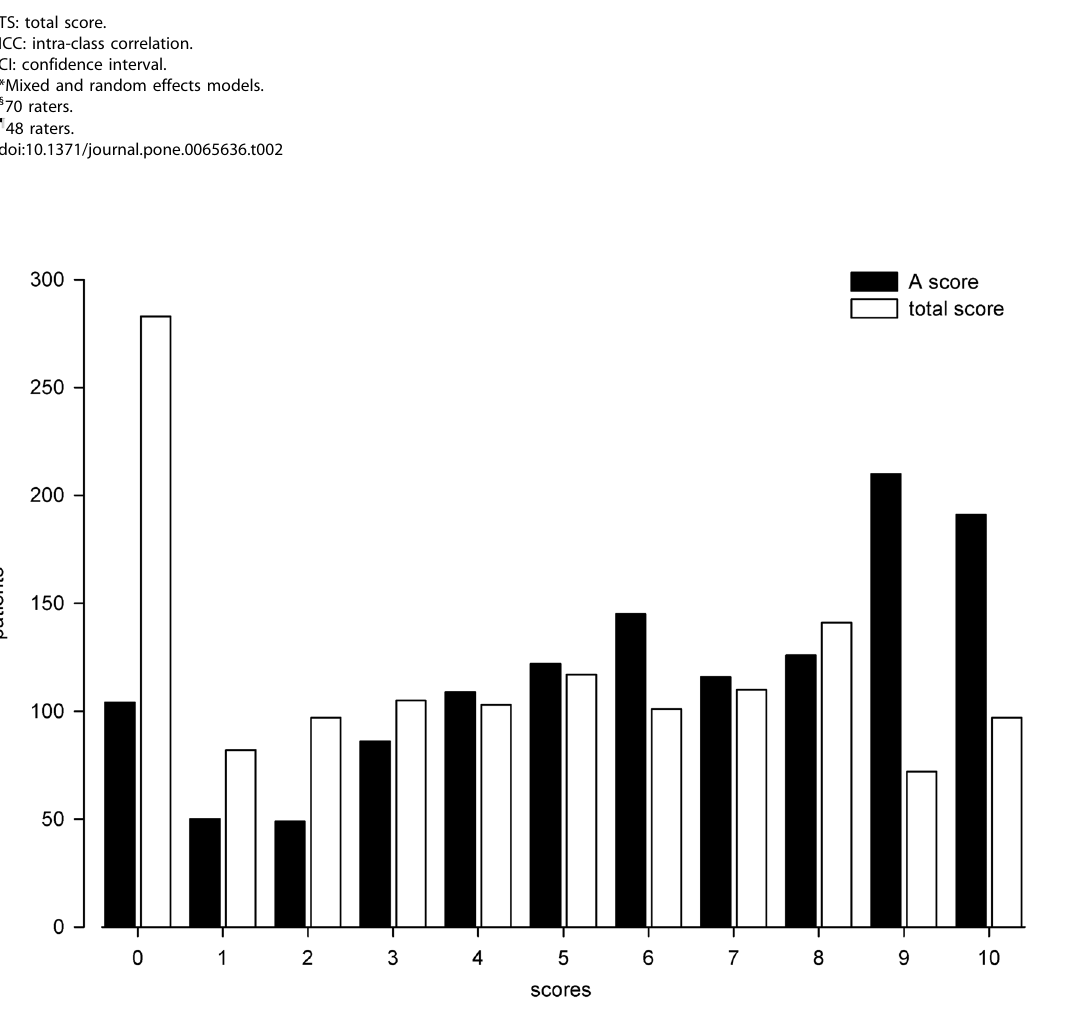
Figure 1. Distribution of total and A scores in the Consortium on Lithium Genetics sample. Histogram plot of the scale scores in 1,308 bipolar disorder patients characterized for response to lithium maintenance